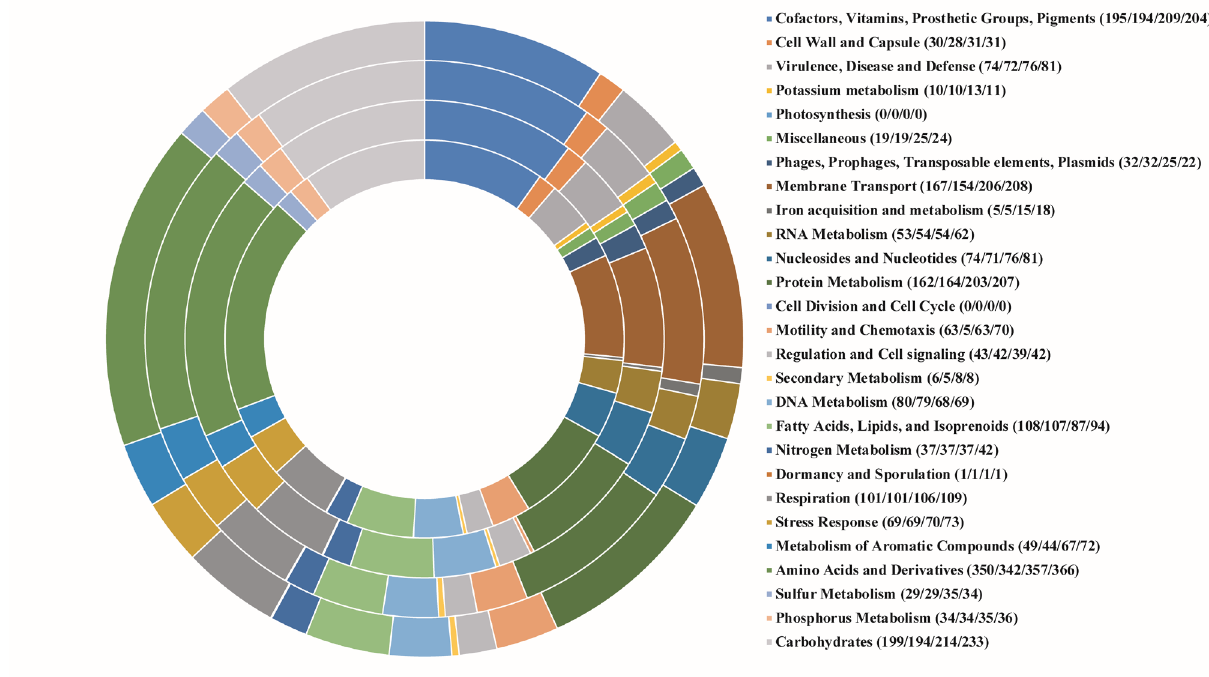
Figure 1 – Distribution of the subsystem category and gene coverage of isolates of Ralstonia solanacearum causing Sergipe facies (SFC and IBSBF2570) and Bugtok disease (CIP417 and Molk2). The graphic representation shows the grouping of genes from the SFC, IBSBF2570, CIP417, and Molk2 genomes from the inside to out. The numbers between parentheses in the legend represent the number of genes in each subsystem in the same